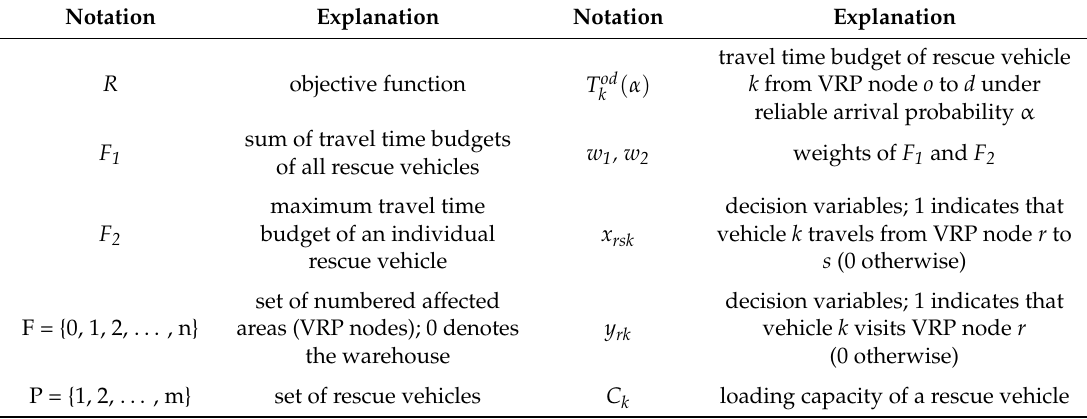
Table 1. List of mathematical annotations used in the proposed model.